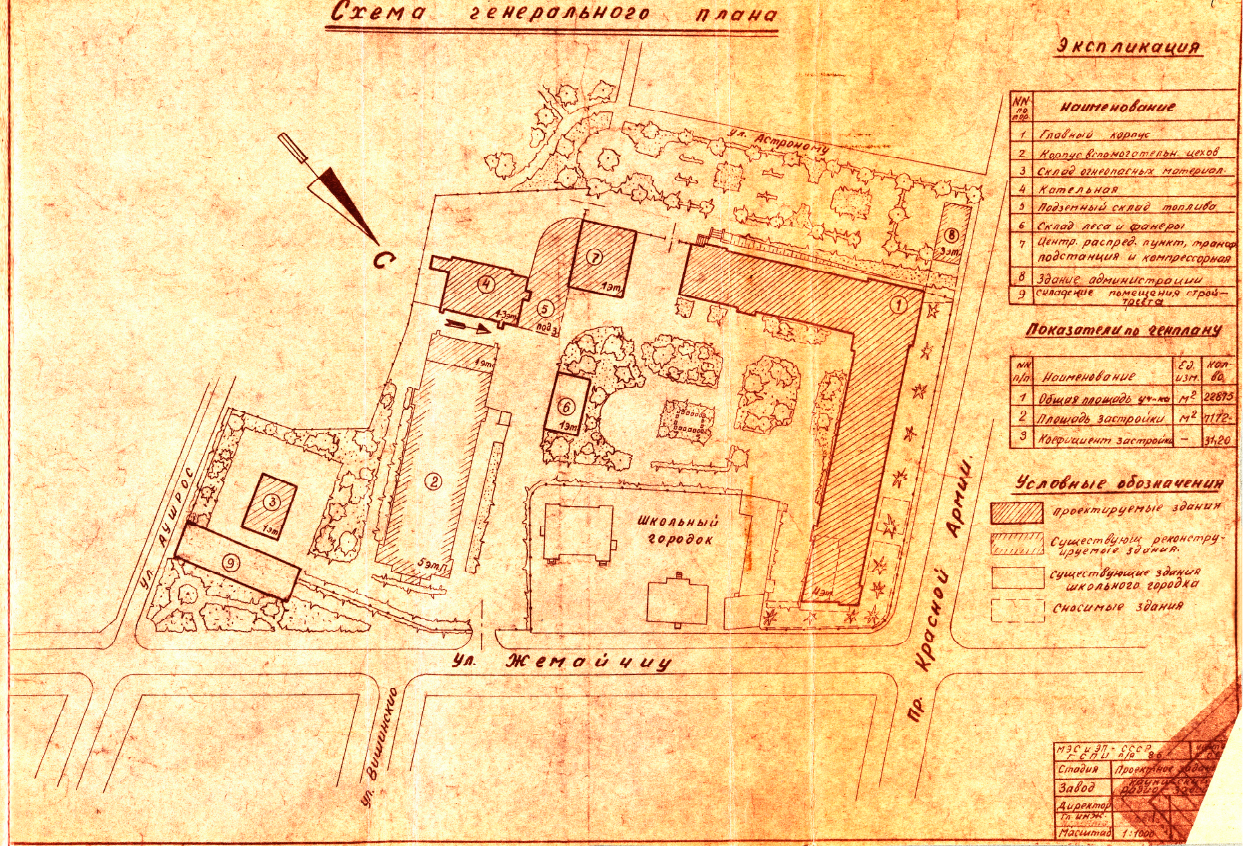
Figure 11. The General Plan scheme of the Kaunas Radio Factory, 1957. (1) Main factory building; (2) Building of auxiliary workshops; (3) Flammable material storage; (4) Boiler room; (5) Underground fuel storage tanks; (6) Plywood warehouse; (7) Electrical substation; (8) Administration buildings (source: Lithuanian Central State Archives).